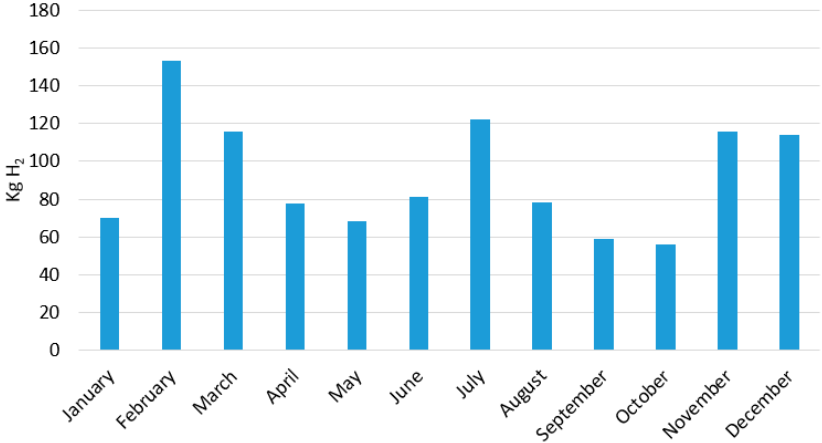
Figure 6. Monthly hydrogen production in 2014.